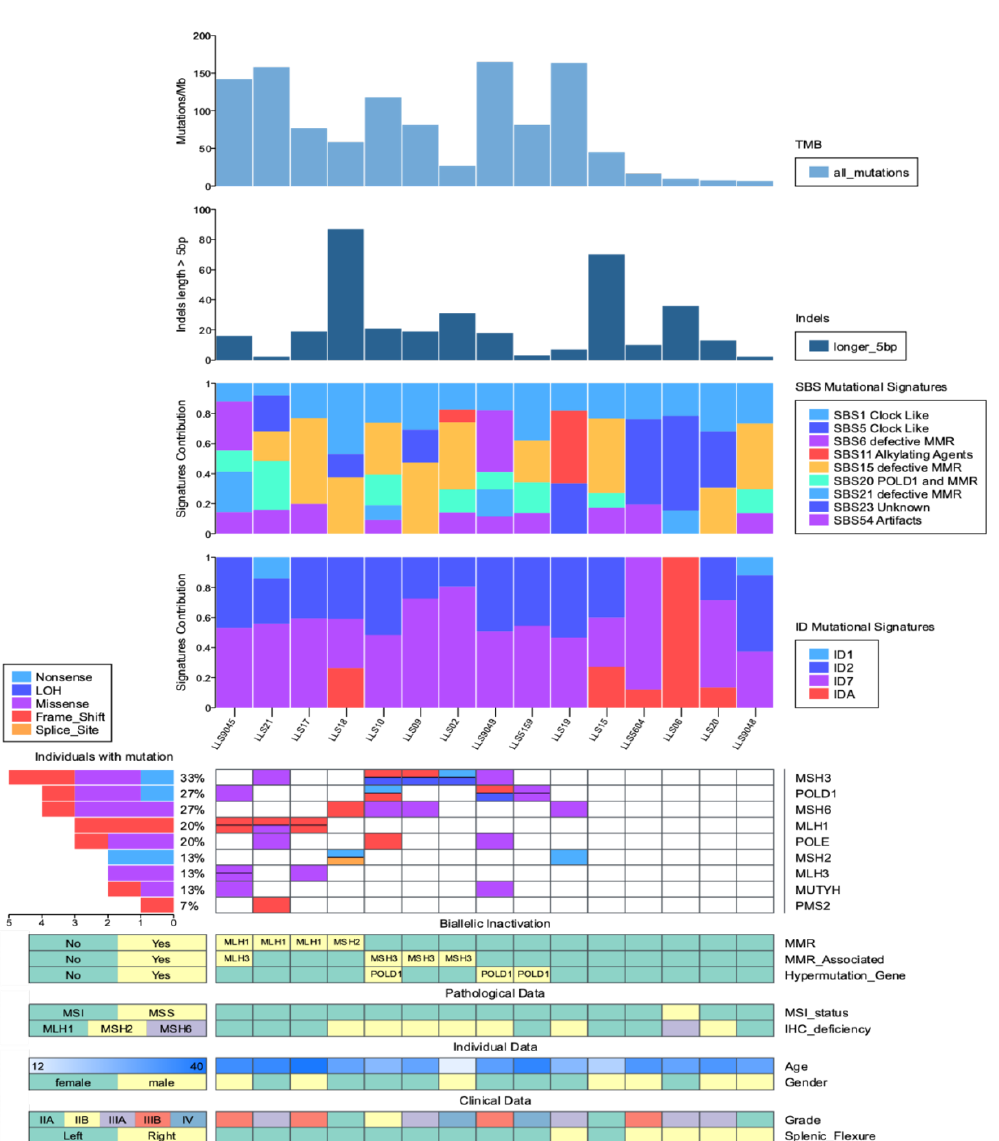
Figure 1. Genomic landscape of 15 early-onset colorectal cancer LLS patients. Samples are organized from left to right as MMR core genes biallelic inactivation, MMR-associated inactivation and hypermutated genes inactivation. Abbreviations TMB = tumor mutational burden (mutations/megabase); SBS = single base substitution; ID/Indels = short insertions and deletions; LOH = loss of heterozygosity.